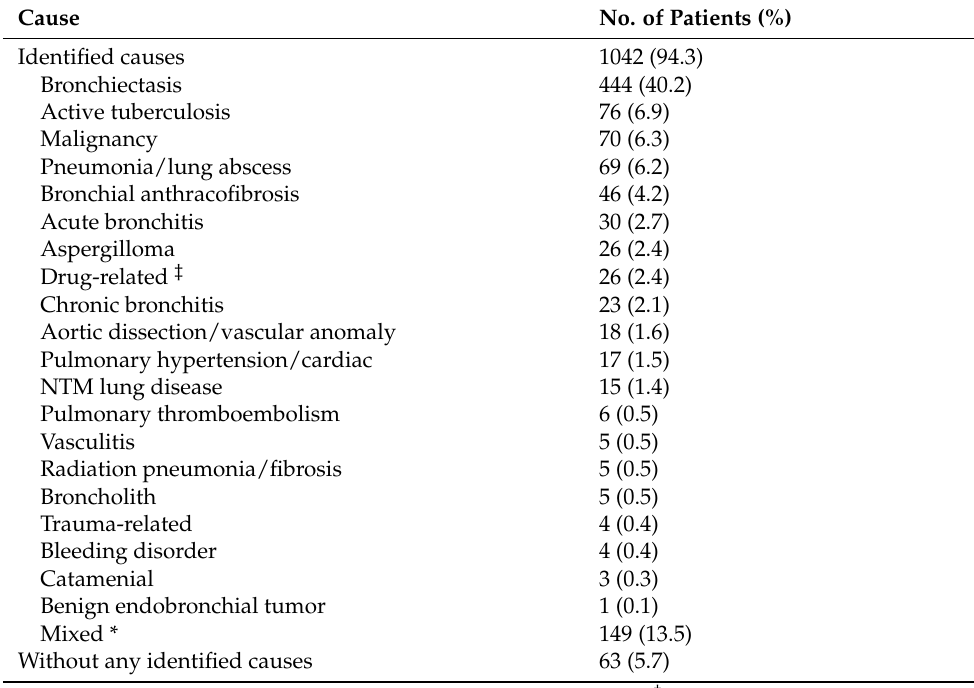
Table 1. Etiology of